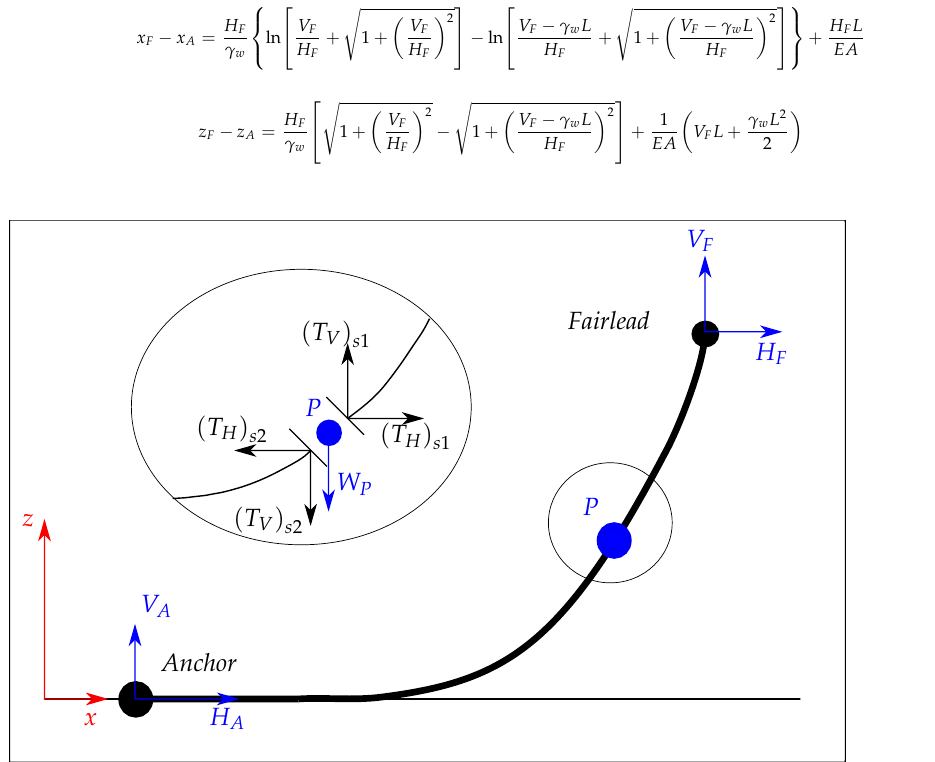
Figure 9. Free body diagram of a mooring line with a clumped weight positioned at point